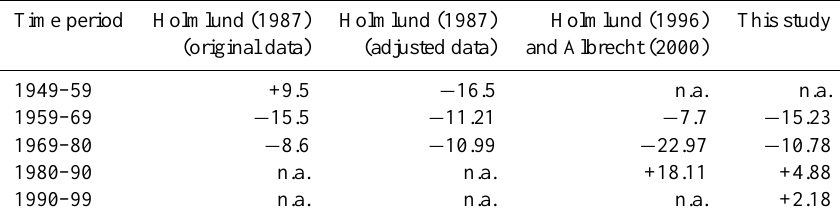
Table 7. Comparison of the volume change [10 6 m 3 ] at Storglaci¨aren from the results of Holmlund (1987), Holmlund (1996) and Albrecht et al. (2000), and this study. The results by Holmlund (1996) and Albrecht et al. (2000) are probably based on the glacier areas described in Holmlund et al.